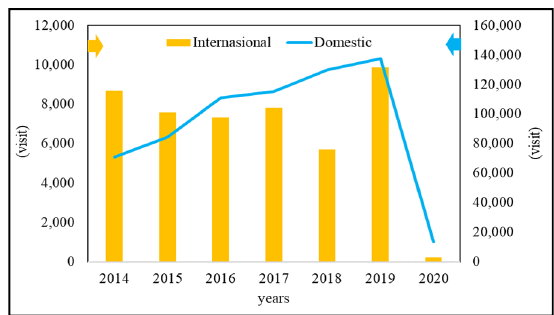
Figure 4. Tourist visit to Karimunjawa Island 2014–2020.